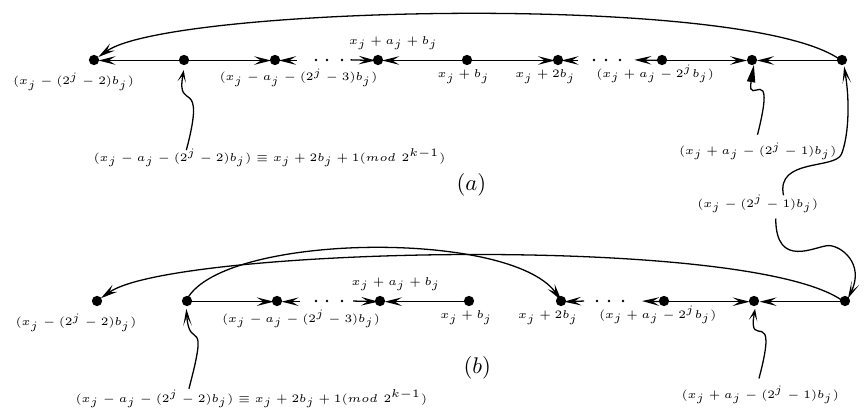
− 1 Fig. 6: Figure 6(a) shows the cycle ~C 2 j j,o as in (4) above and Figure 6(b) shows the reconstructed anti-directed path ~H 2 j − 1 x j − (2 j − 2) b j and terminus x j + b j . j,o with origin